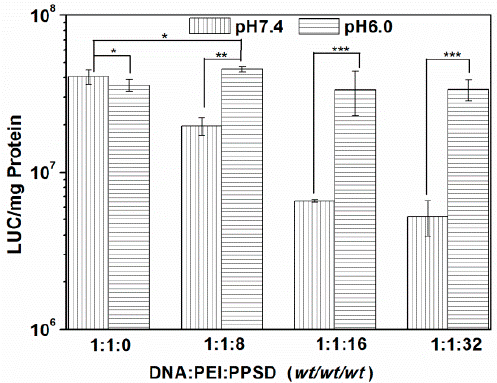
Figure 6. Transfection efficiency of the ternary complex at pH 7.4 and 6.0 in HeLa cells. *, p > 0.05; **, 0.01 < p < 0.05. ***, p < 0.01.